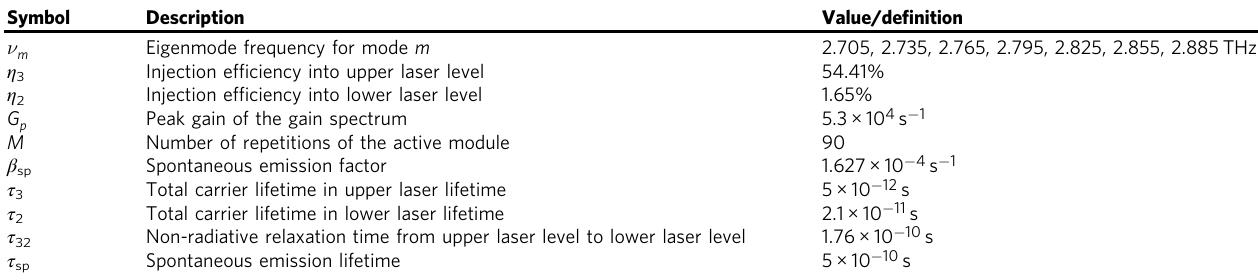
Table 1 Quantum cascade laser parameters used in reduced rate equation based numerical simulations